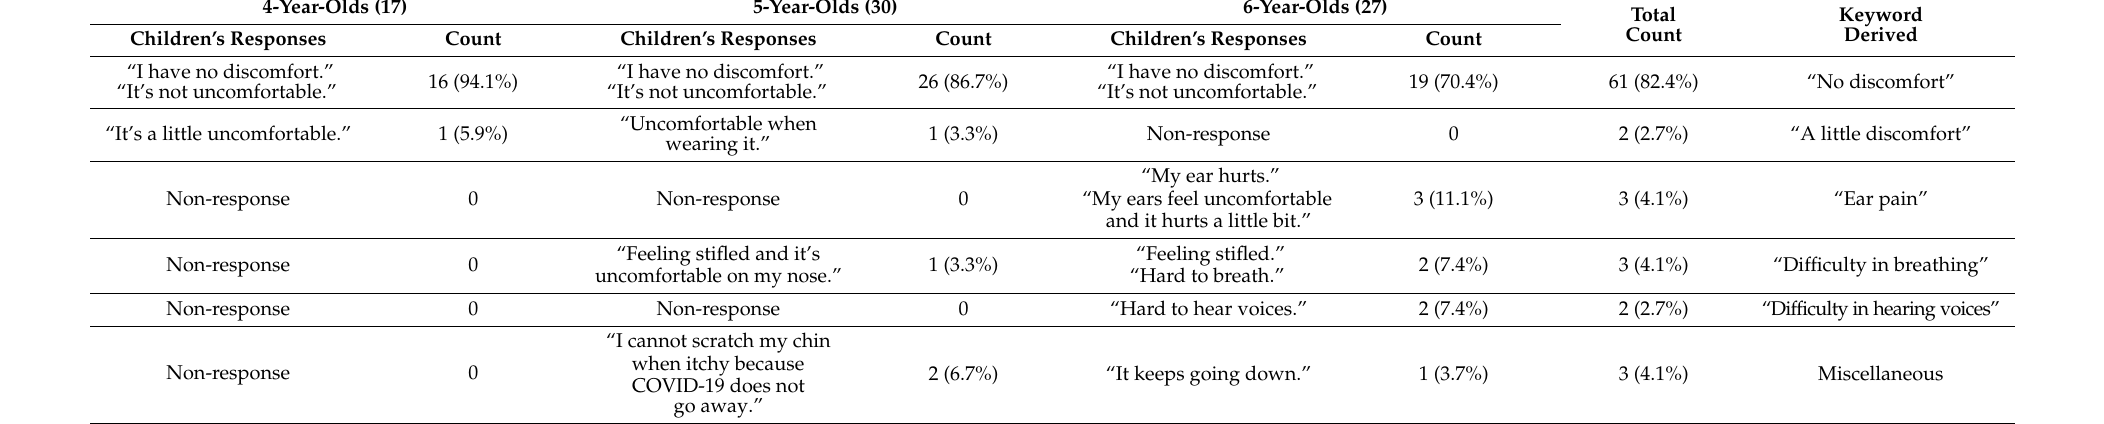
Table 6. Children’s responses to subjective question No. 2: What are the discomforts of wearing a